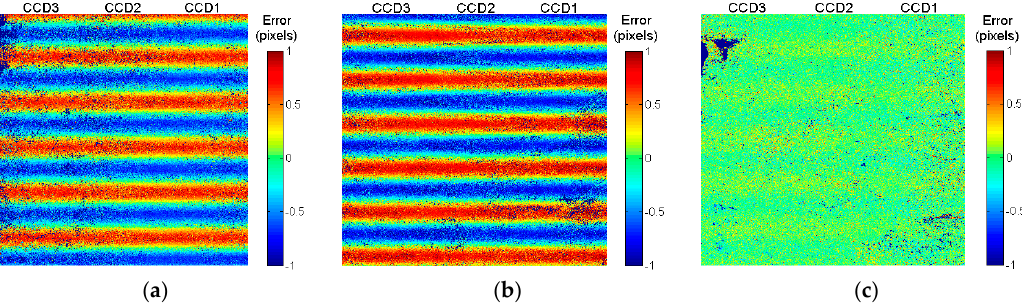
Figure 9. Parallax images between B1 and B2 across the track of ( a ) Scene A, ( b ) Scene B, and ( c ) Scene C.